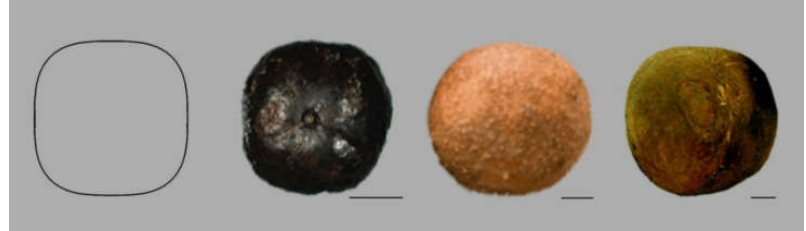
Figure 8. The squared circle (model) and representative examples of seeds adjusting to it (between parentheses the values of J index with the respective models): Clinosperma macrocarpa (91.5), Johannesteijsmannia altifrons (92.4), and Mauritia flexuosa (92.0). In C. macrocarpa the seed is orientated with the stem end in a central position, while the other seeds present a side view. The model is defined by Equation (6) with a = b = 1, and p =